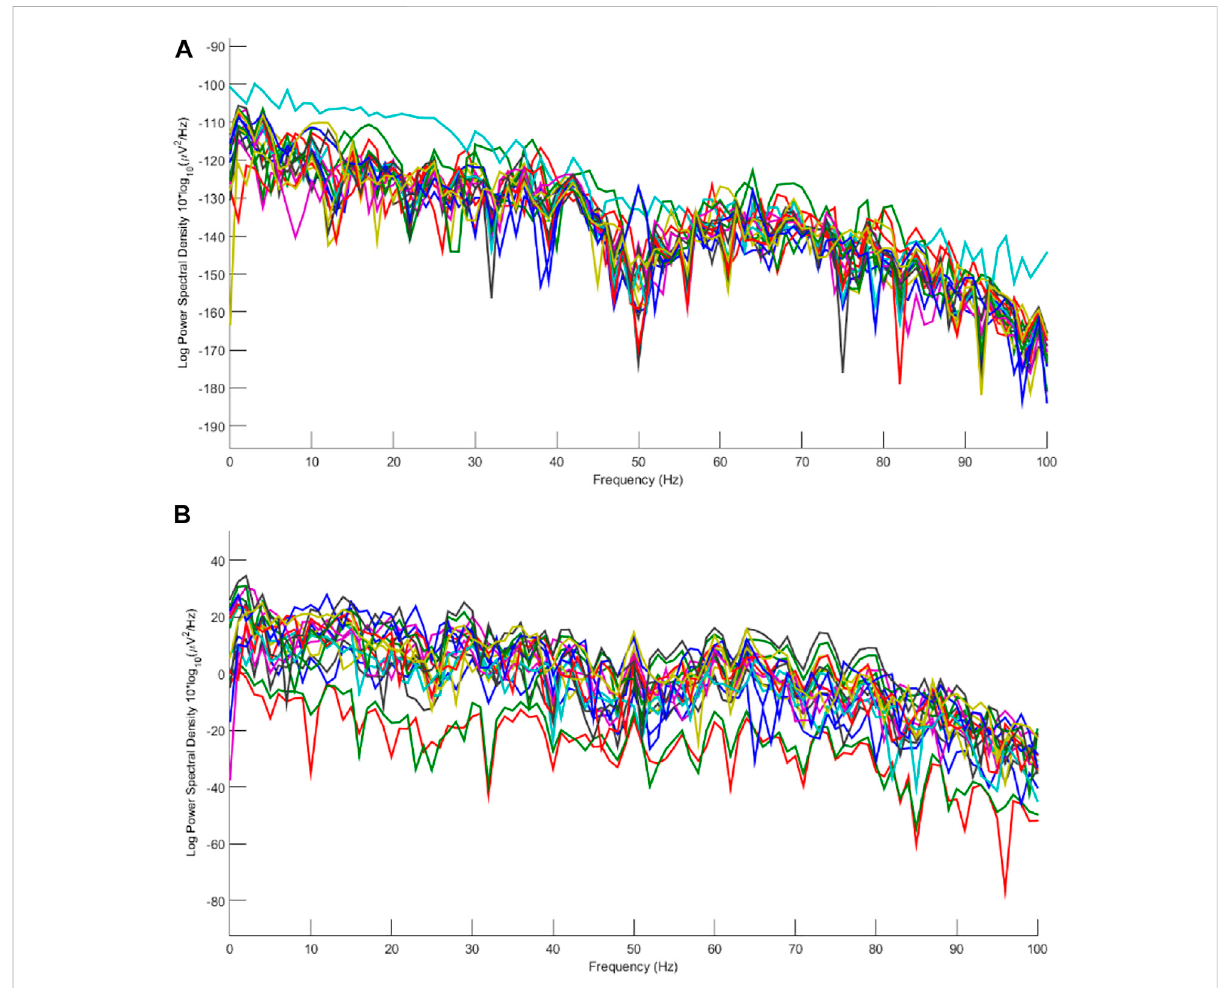
FIGURE 11 Power spectral density of channels for (A) contaminated real and (B) cleaned